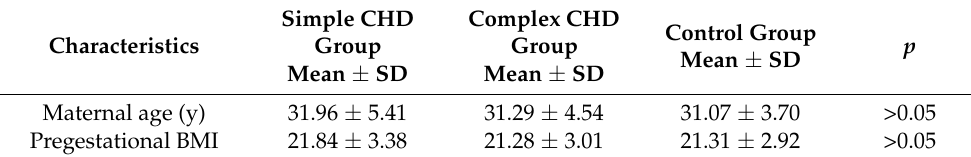
Total 197 VSD, ventricular septal defect; COA, coarctation of the aorta; PS, pulmonary stenosis, TOF, tetralogy of Fallot; TGA, transposition of great arteries; HLHS, hypoplastic left heart syndrome; HRHS, hypoplastic right heart syndrome; DORV, double outlet of right ventricle; TVD, tricuspid valve dysplasia; AVSD, atrioventricular septal defect; SV, single ventricle; IAA, interruption of aortic arch; PA, pulmonary atresia; TA, tricuspid atresia; PTA, persistent truncus arteriosus; HCM, hypertrophic cardiomyopathy. Table 2. Maternal characteristics of the case and control group.